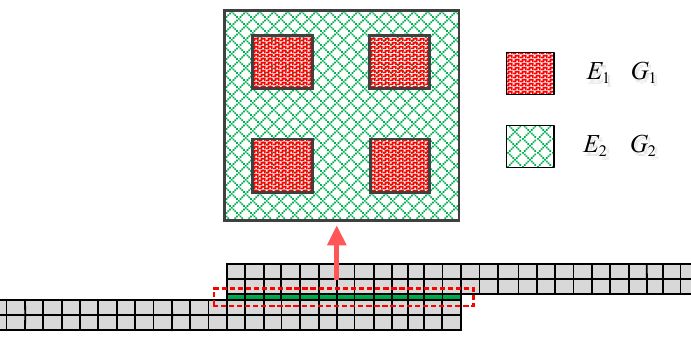
Figure 13. FEM of the connection structure.